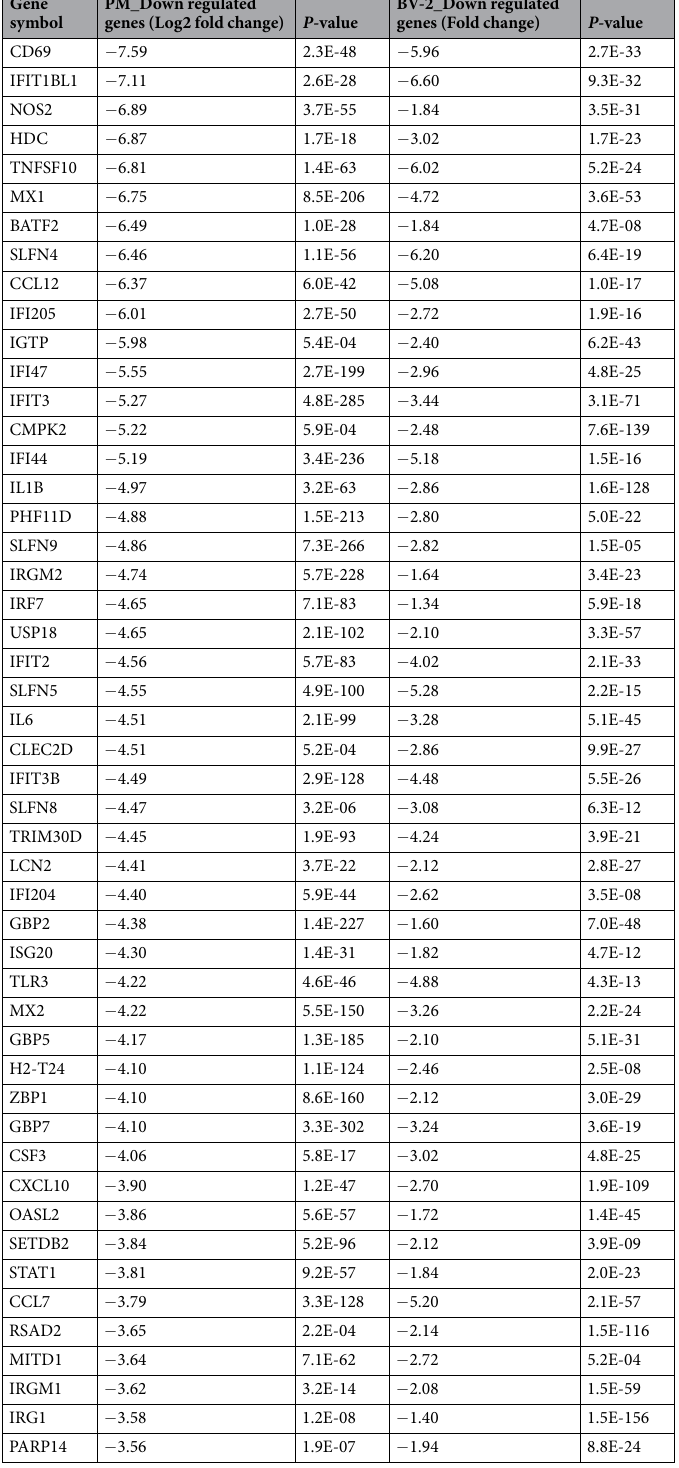
Table 3. Top 50 GSK-J4 down-regulated common genes in LPS treated PM and BV-2 microglial